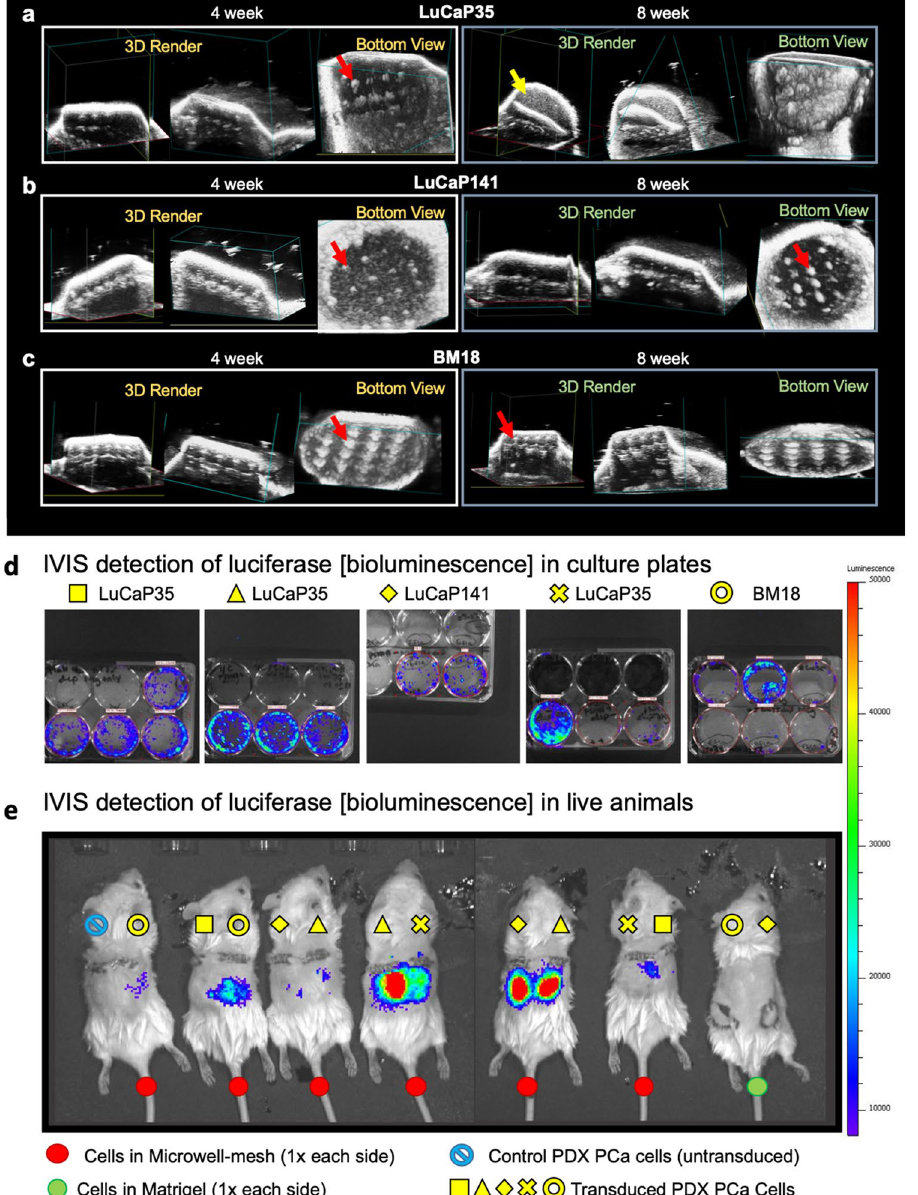
Figure 6. Live animal imaging of microtumours. ( a-c ) Microtumours imaged with the VEVO LAZR at 4 and 8 weeks. Microtumours either appeared as spheroidal and arrayed tissues contained within the Microwell- mesh (red arrows), or as a larger cell mass external to the Microwell-mesh platform following breaching of the Microwell-mesh (yellow arrow). ( d ) Bioluminescence signal from transduced PDX cells cultured in well plates. Each culture is assigned a yellow shape, and this aligns with the cells implanted into animals in caption E. ( e ) Bioluminescence signal from transduced microtumours in Microwell-mesh implanted into mice. Red dot corresponds to animals with Microwell-mesh implanted, green dot corresponds to an animal with transduced cells in Matrigel. Notation from caption D indicates PDX population, i.e. Yellow square = LuCaP35, Yellow triangle = LuCaP35, Yellow diamond = LuCaP141, Yellow cross = LuCaP35, and yellow circle =